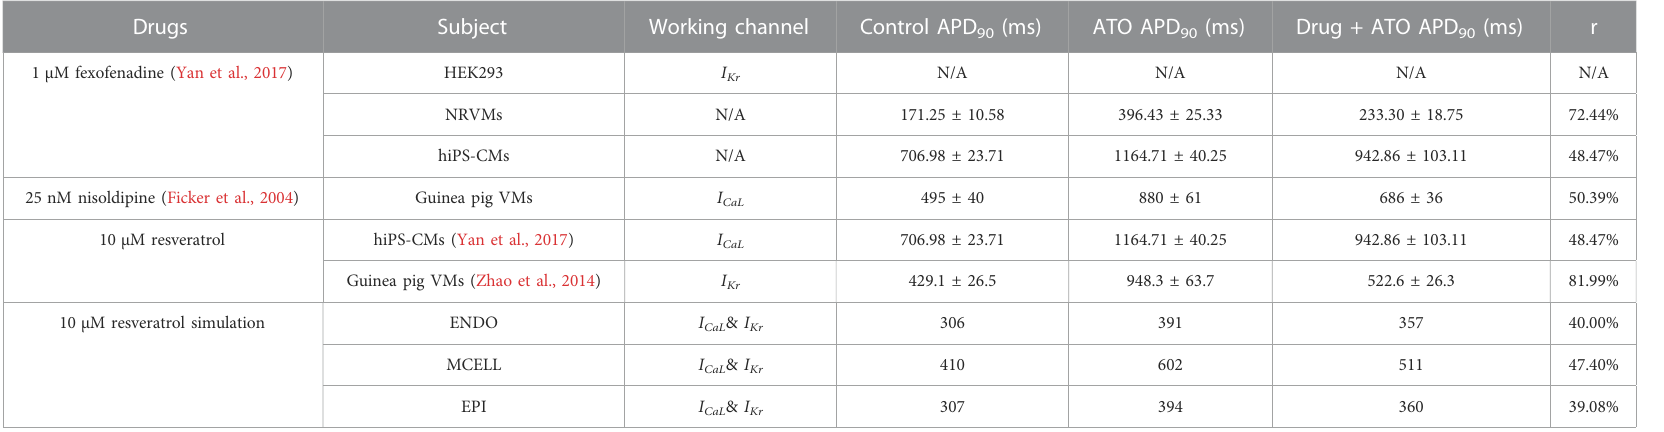
TABLE 4 Effect of drugs on the APD of cardiomyocytes incubated with 3 μ M ATO.